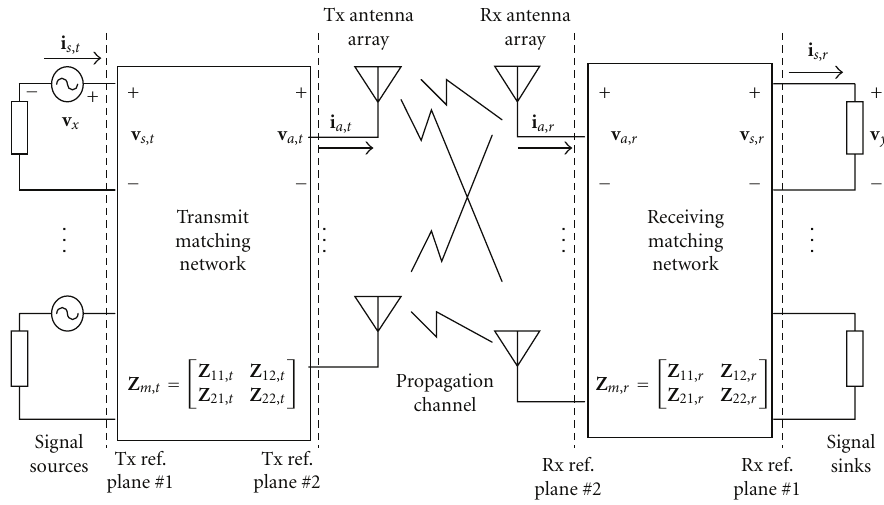
Figure 1: Anaysis framework of the MIMO systems considering mutual coupling and matching